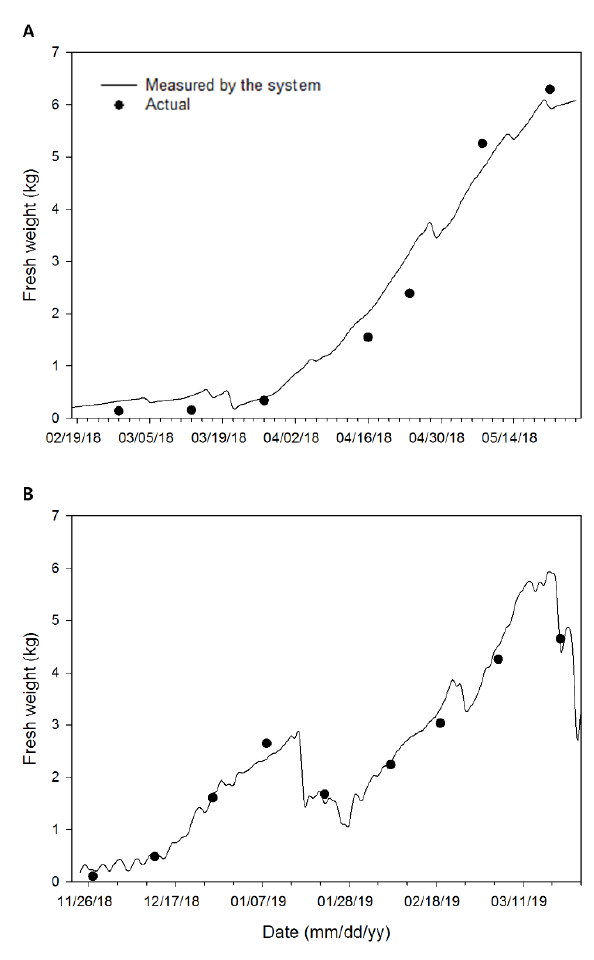
Figure 6. Changes in crop fresh weights measured by the developed system (line) and manual measurements (dot). ( A ) and ( B ) indicate growth periods 1 (8 February–28 May 2018) and 2 (30 October measurements (dot). A and B indicate growth periods 1 (8 Feb. – 28 May, 2018) and 2 (30 Oct., 2018 – 25 2018–25 March 2019), Mar., 2019), respectively.